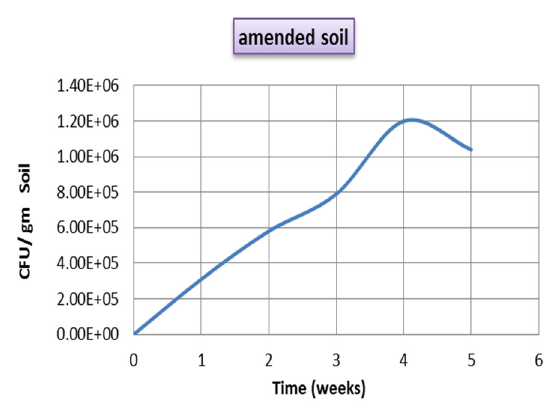
Fig. 5. Changes in counting of diesel-utilizing bacteria for amended soil.